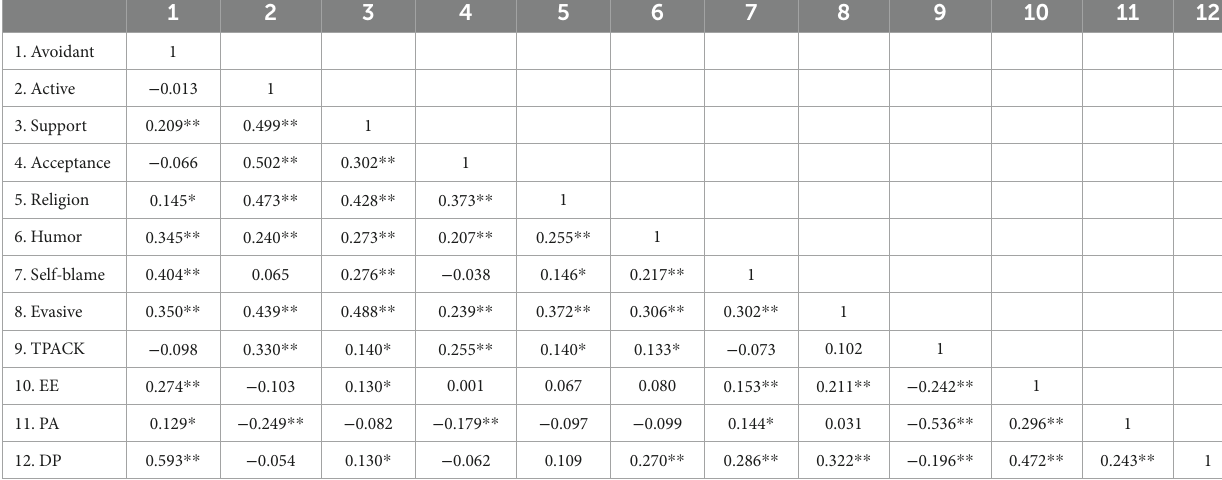
Inter-correlations between the variables: Table 3 shows the correlations between the variables of the study including coping strategies, TPACK, and burnout dimensions.